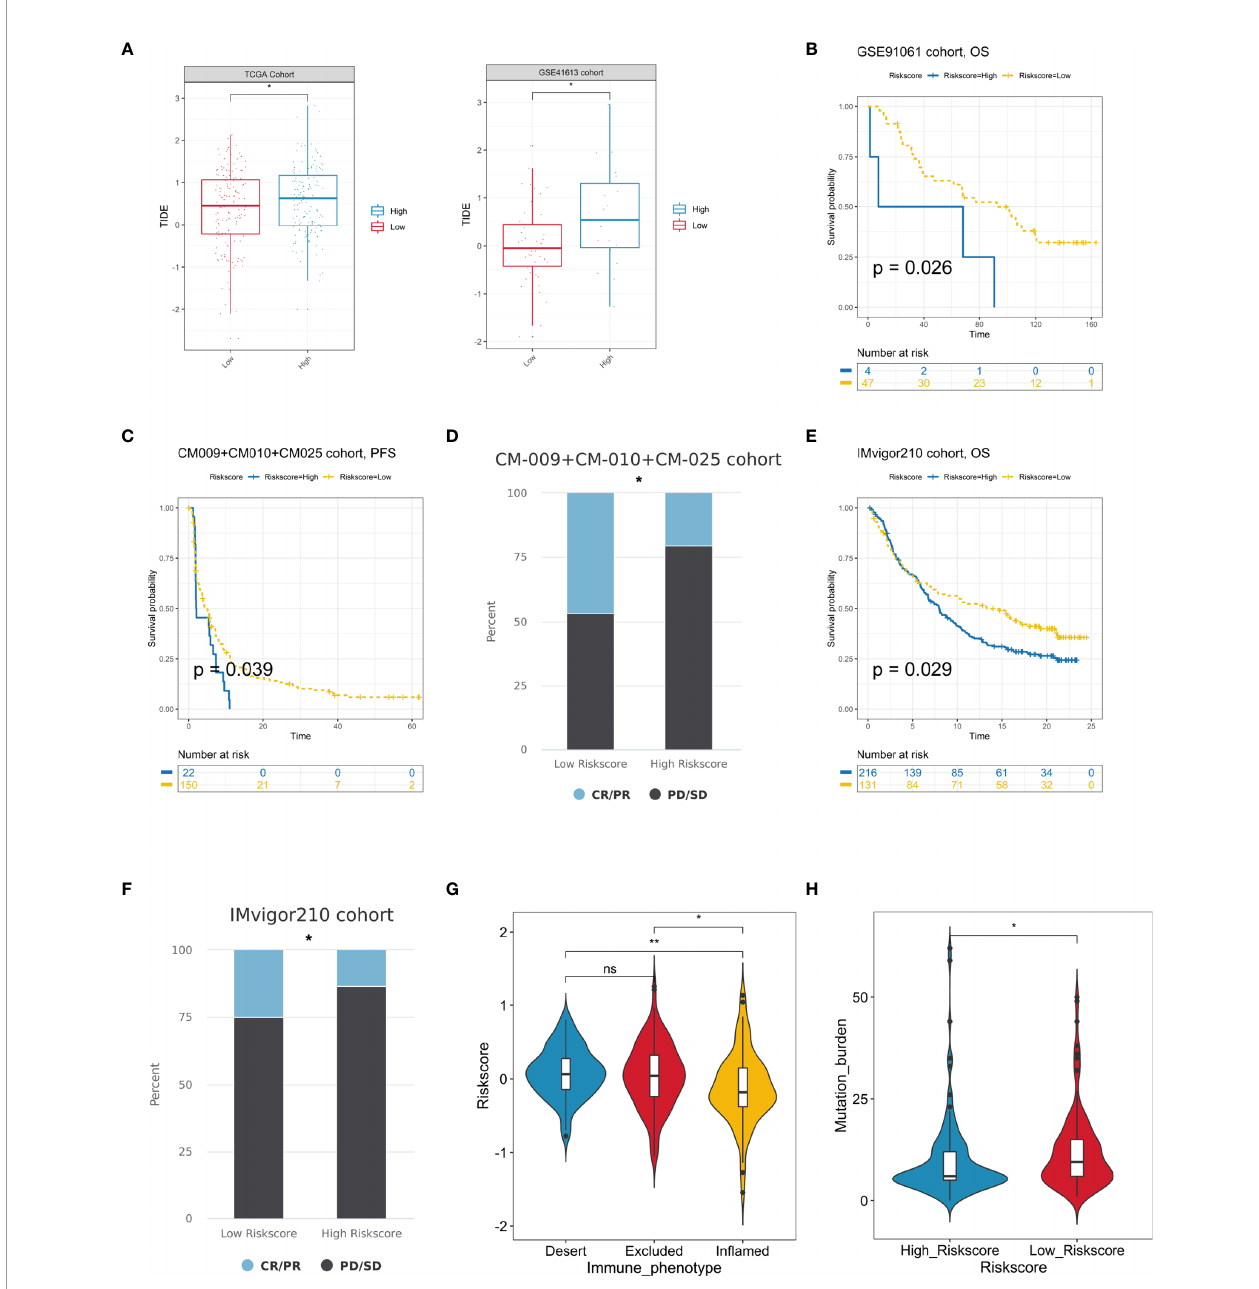
FIGURE 8 | Prediction of immunotherapeutic bene fi ts by hypoxia score. (A) TIDE scores were increased in the high hypoxia risk score group in the TCGA and GSE41613 cohorts. (B, C) The survival analysis of the high and low hypoxia risk score groups in the GSE91061 and CM-009+CM-010+CM025 immunotherapy cohorts. (D) The immunotherapy response patients (CR/PR) more distributed in lower risk score patients, while non-response ones (PD/SD) enriched in higher risk score patients in the CM-009+CM-010+CM025 cohorts. (E) High-risk score patients occupied a signi fi cantly reduced overall survival in the Imvigor210 cohort. (F) Various fractions of clinical outcome patients in the high and low hypoxia risk score groups in the IMvigor210 cohort. (G) The difference of hypoxia risk scores in the three immune subtype groups in the IMvigor210 cohort. (H) Differences in TMB between high- and low-risk score groups in the IMvigor210 cohort (ns, no signi fi cance, * P < 0.05, ** P <